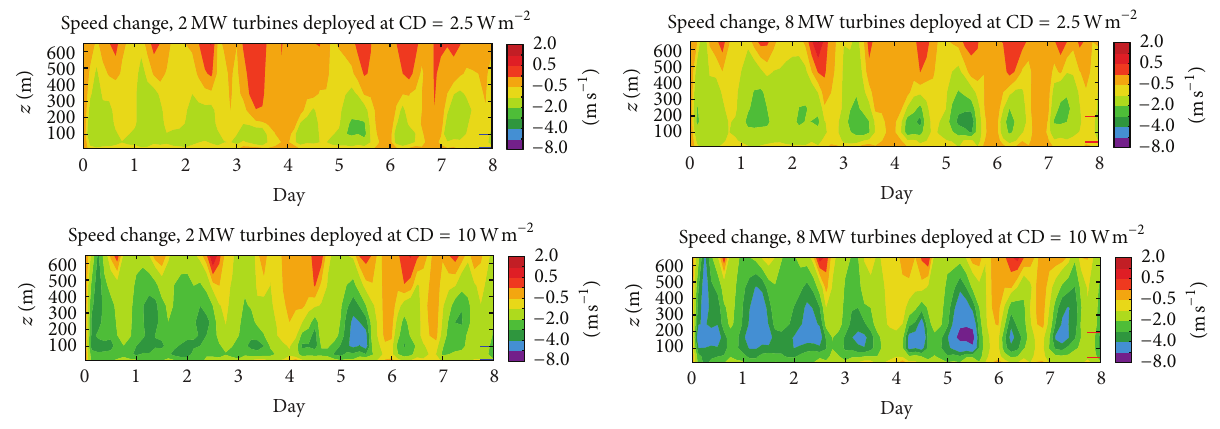
Figure 6: Area-averaged wind speed change that results from deploying wind turbines, as a function of height and time. The height of the top and bottom of the rotor are indicated by longer tick marks at the extreme right. The extent of the wind reduction above the tops of the turbines is indicative of power extraction from those layers, a complicated prediction requiring a numerical weather prediction model.